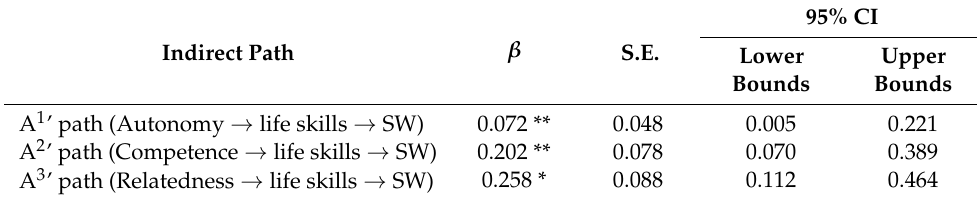
95% CI Lower Upper Bounds Bounds